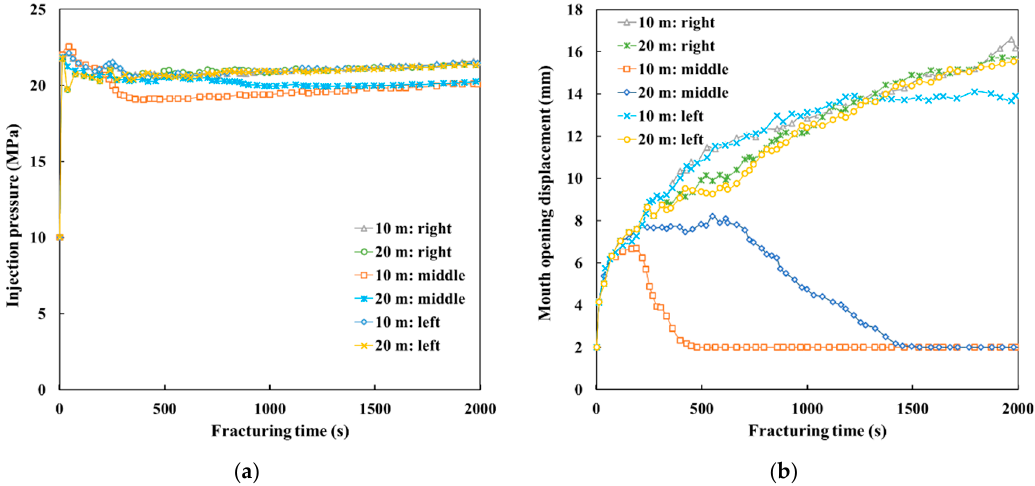
Figure 10. Variation of injection pressure and mouth opening displacement with different closely-spacing simultaneous fracturing: ( a ) Variation of injection pressure; ( b ) Variation of mouth opening displacement.